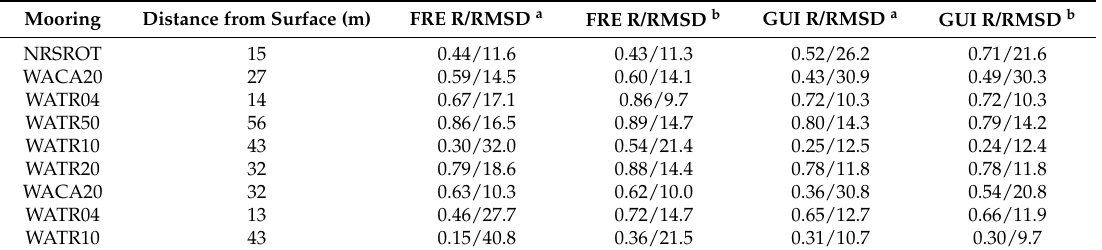
Table 2. Effects of velocity thresholds on radar data: a , no threshold applied; b , 1.5 m/s (absolute value) threshold